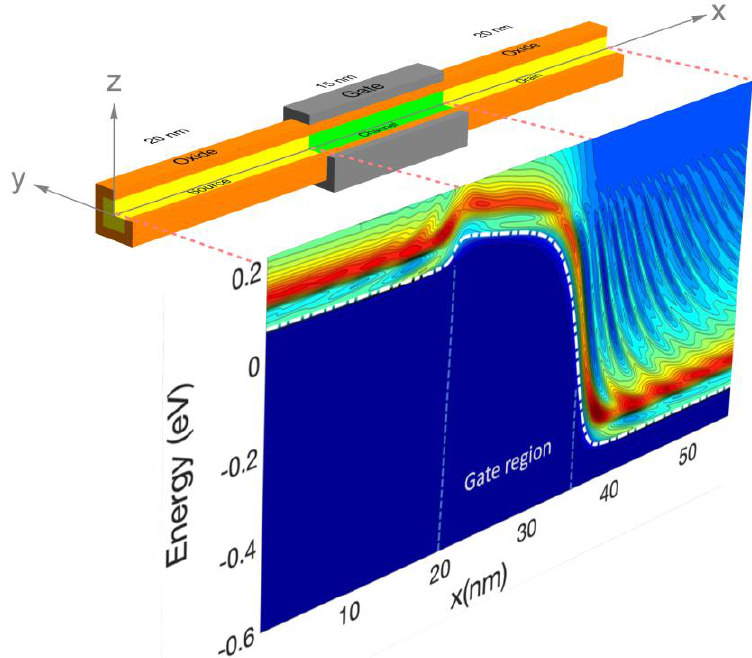
Figure 2. Schematics of a wrap-round gate silicon nanowire field-effect transistor of length 55 nm cut away to expose the channel region. The oxide thickness is 0.8 nm and the channel width is 2.2 nm. The channel length (gate length) is 15 nm, the source and drain extensions are 20 nm. The work function of the metal gate is 4.5 eV. The projected image shows a typical non-equillibrium Green function (NEGF)-computed local density of states (LDOS) for the device assuming a drain bias of 0.6V and a gate bias at 0.6 V. The location of the first 1D sub-band edge is shown along the central nanowire x-axis as a function of energy and position (dashed white line); it mimics the self-consistent potential along the same axis. In the projected image, the vertical energy scale is from − 0.6 eV to 0.23 eV.